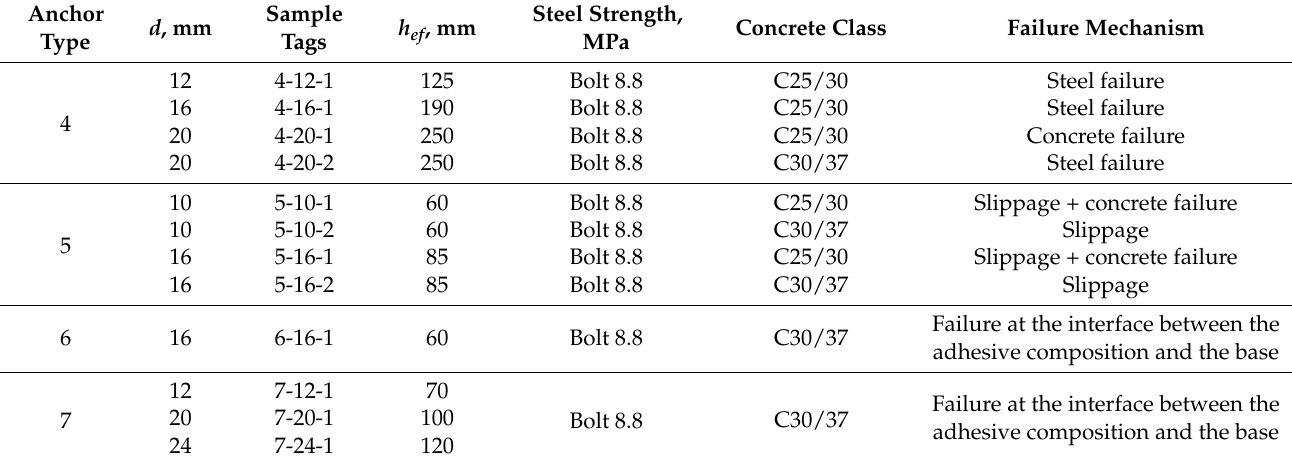
Table 4. Post-installed anchor failure